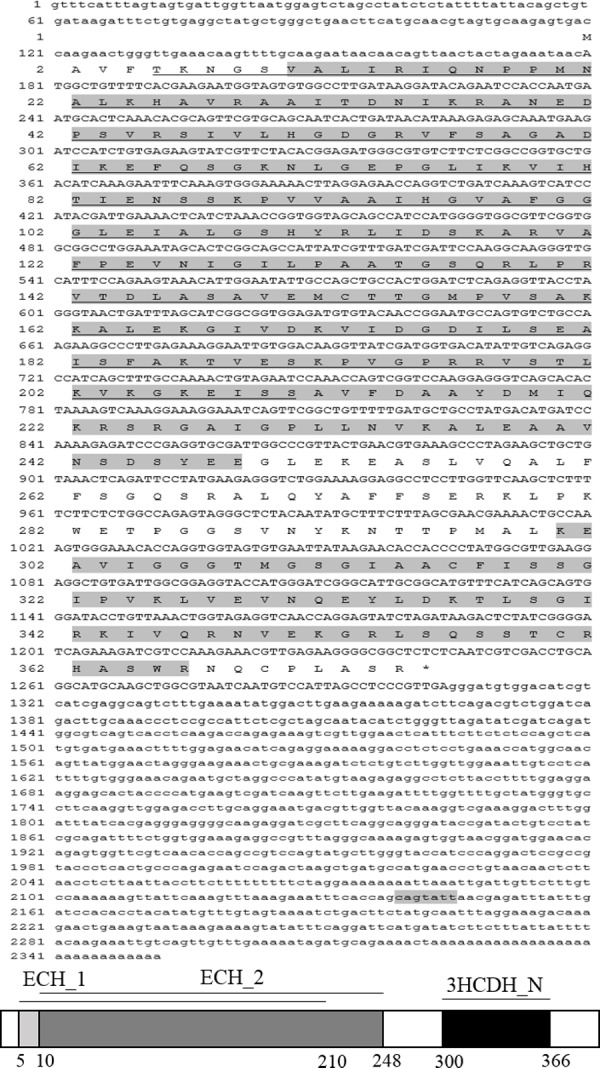
The complete cDNA sequence and deduced amino acid sequence of AjEHHADH from A. japonicus.Amino acids are numbered starting with the N-terminal Met residue. The asterisk indicates the translational termination codon. The open reading frame (ORF) from the initiation codon (ATG) to the termination codon (TAG) is notated by uppercase letters. At the bottom of the page is the schematic diagram of domains and characteristic motifs.